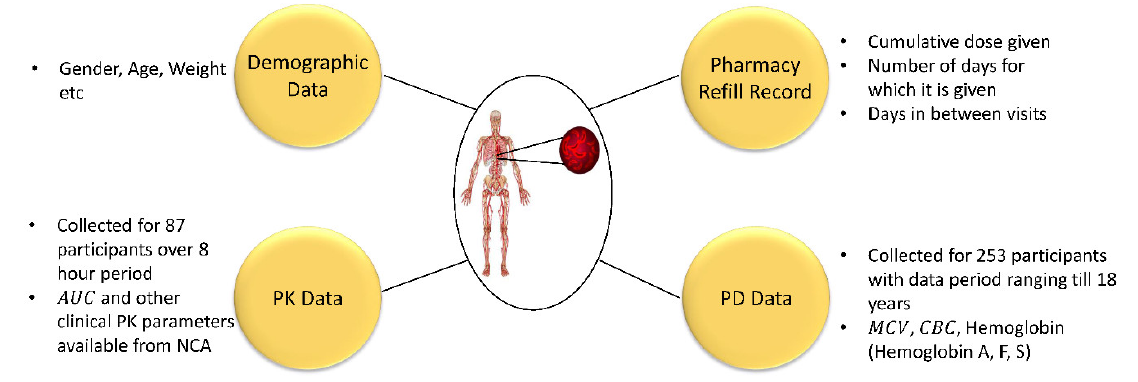
Figure 1. Description of HUSTLE participants’ data components. Table 1. Summary of participants with SCD characteristics.